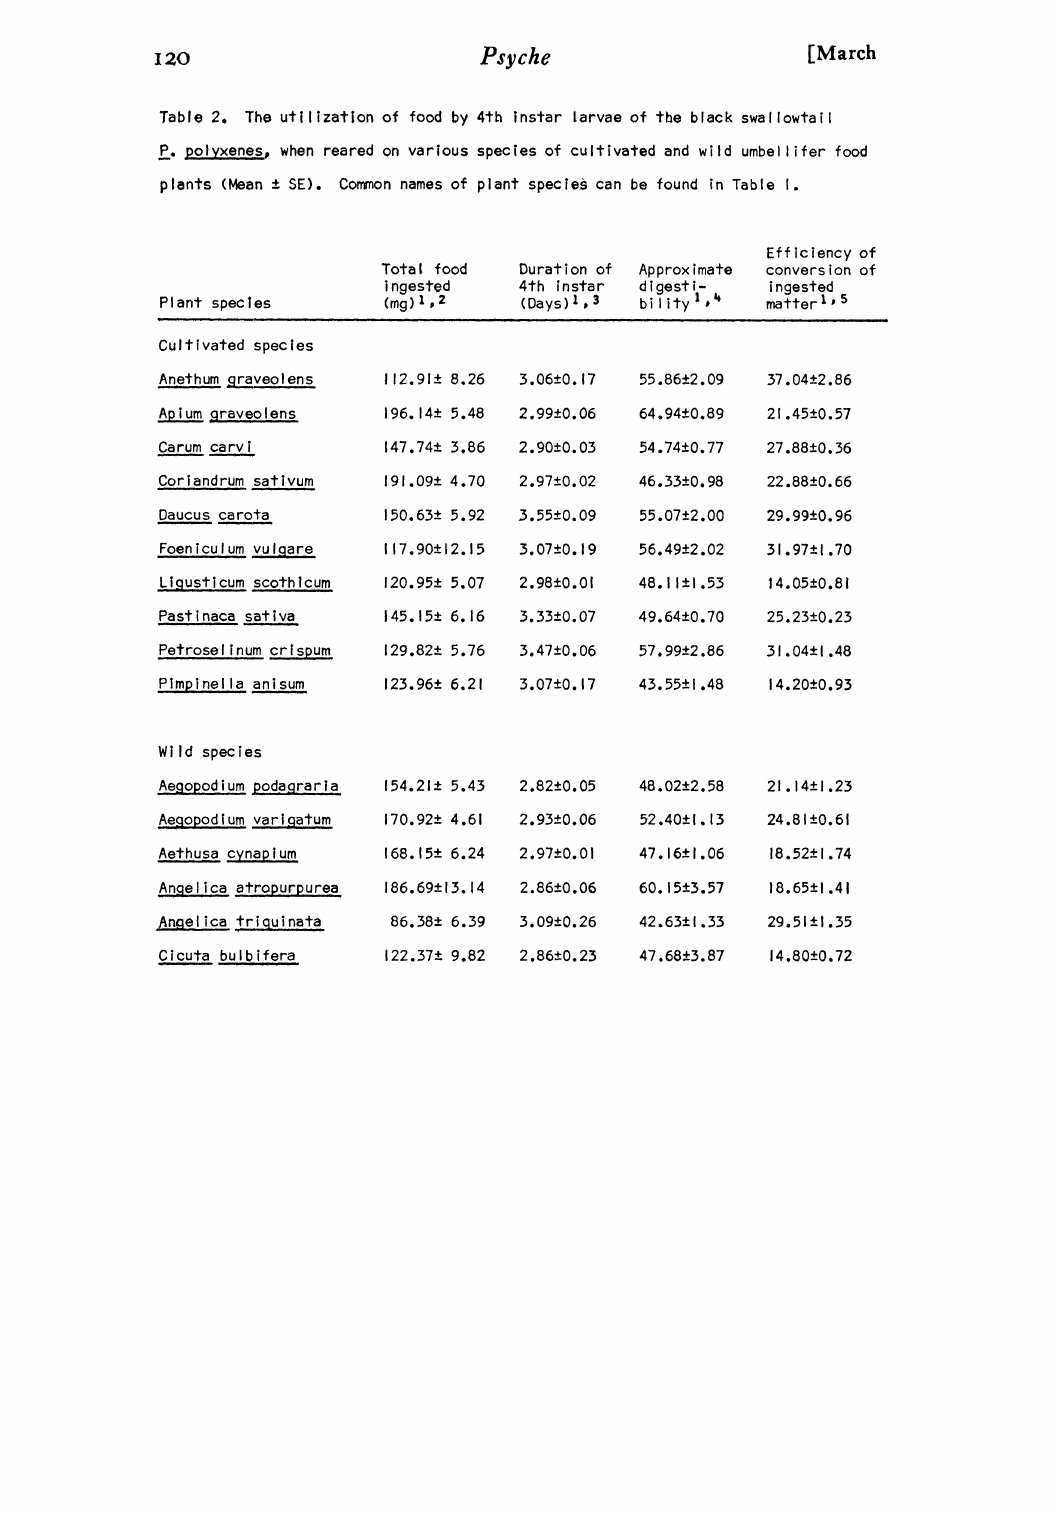
. Table 2. The utilization of food by 4th instar larvae of the black swallowtail oolyxenes, when reared on various species of cultivated and wild umbellifer food plants (Mean +/- SE). Common names of plant specie can be found in Table